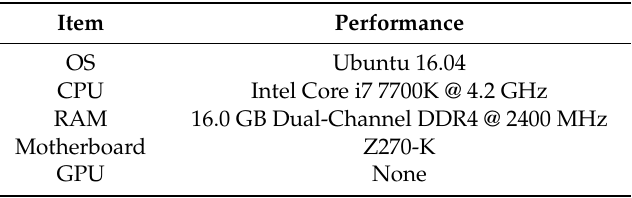
Table 4. Desktop PC (B)